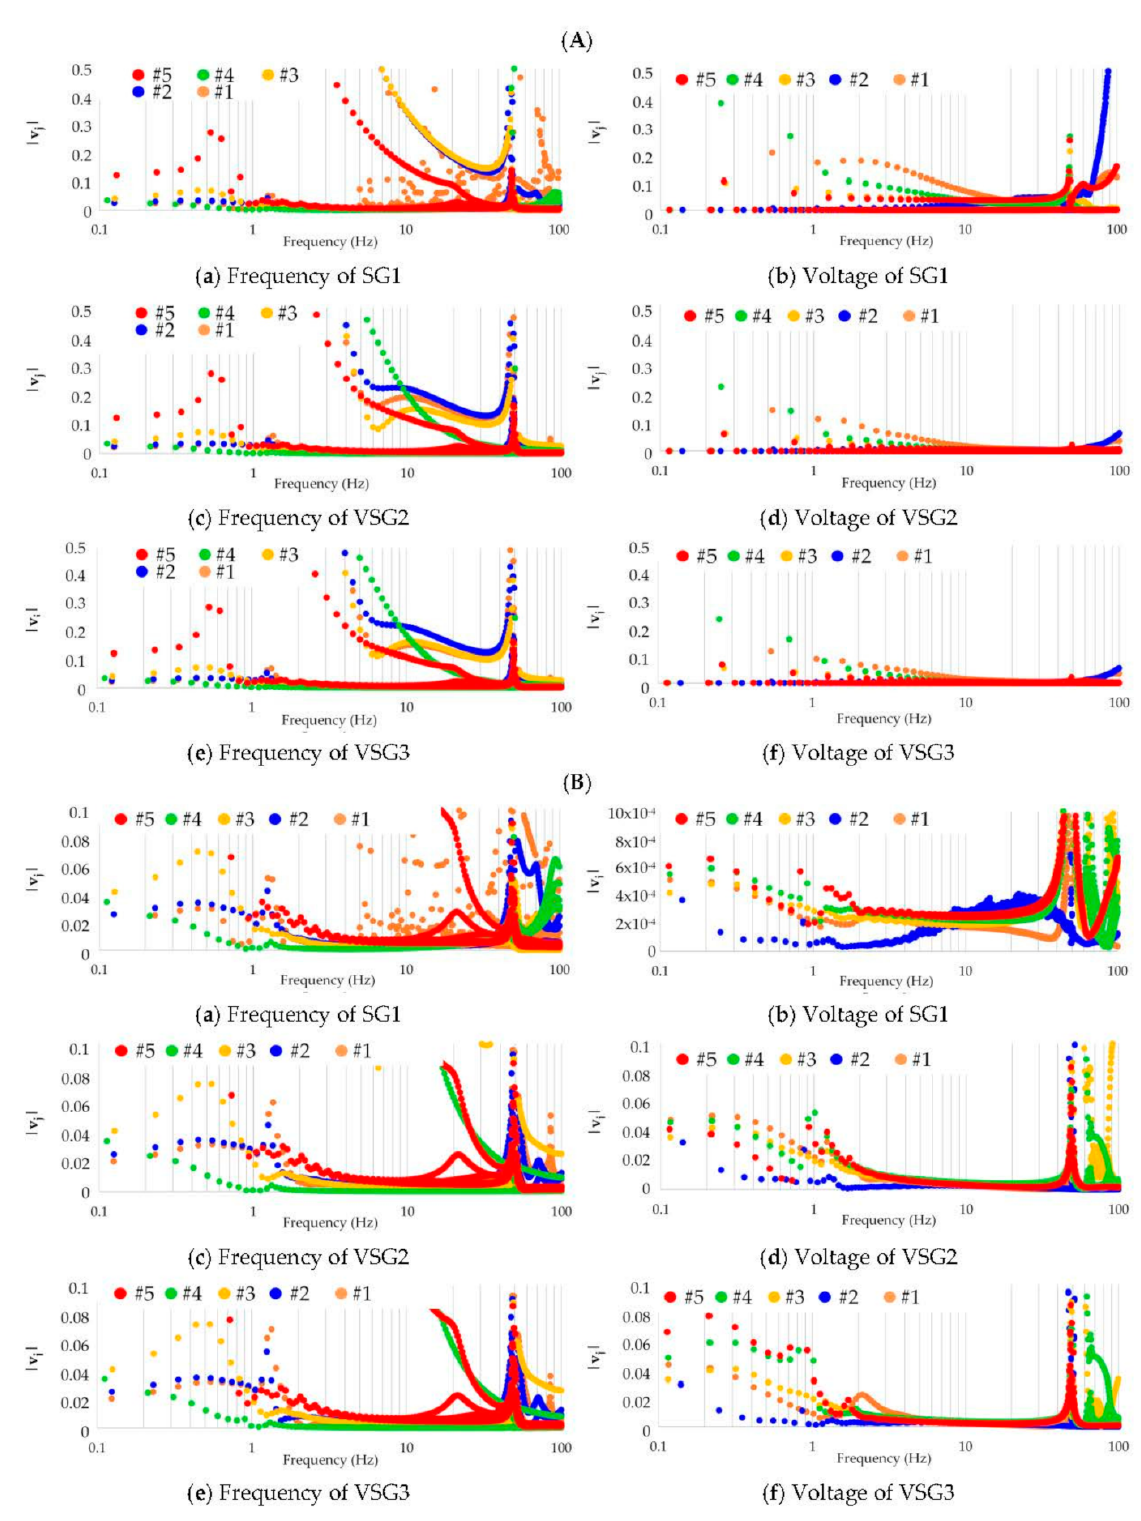
Figure 12. ( A ) Frequency response of the KMs of the system frequency/voltage for tests 1–5 in Table 1. ( B ) Frequency response of the KMs of the system frequency/voltage (enlarged | v i | ) for tests 1–5 in Table